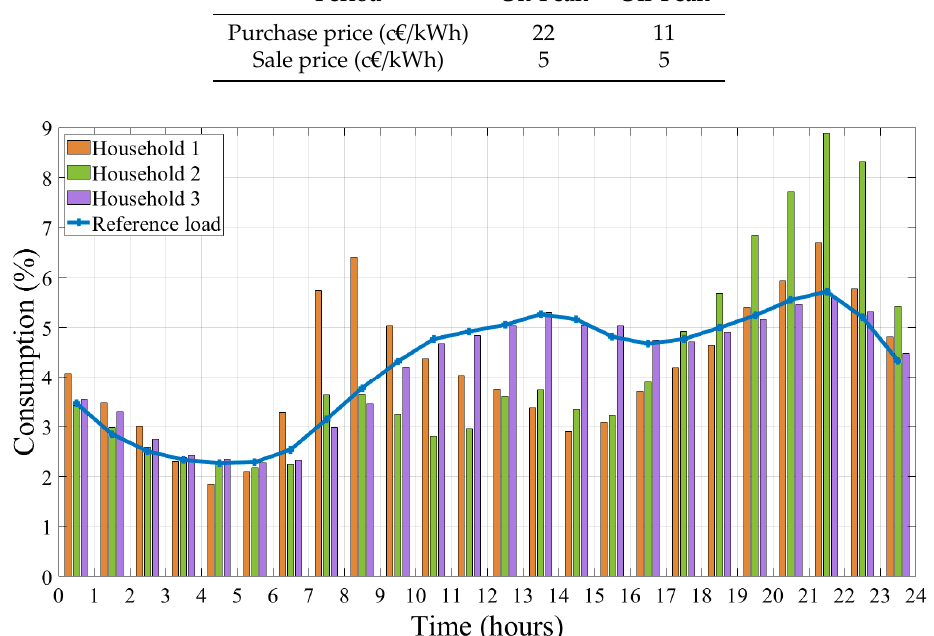
Figure 5. Load distribution profile for the three households analyzed, and reference load curve used as model.